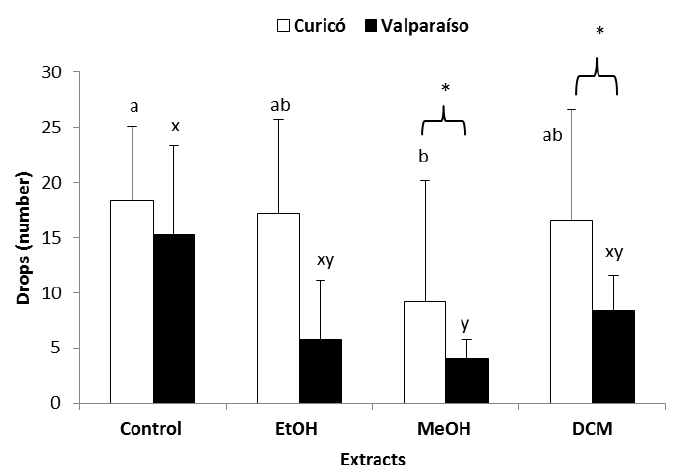
Figure 3. Antifeedant activity on Diaphorina citri adults. Results are shown as means ± SD of honeydew droplets. Different letters indicate significant differences (ANOVA, Tukey p < 0.05) among the Curicó extracts (open bars; a, b) or among the Valparaiso extracts (solid bars; x, y). Asters indicate significant differences between the same kind of extracts from different locations (* ANOVA, Tukey p < 0.05).